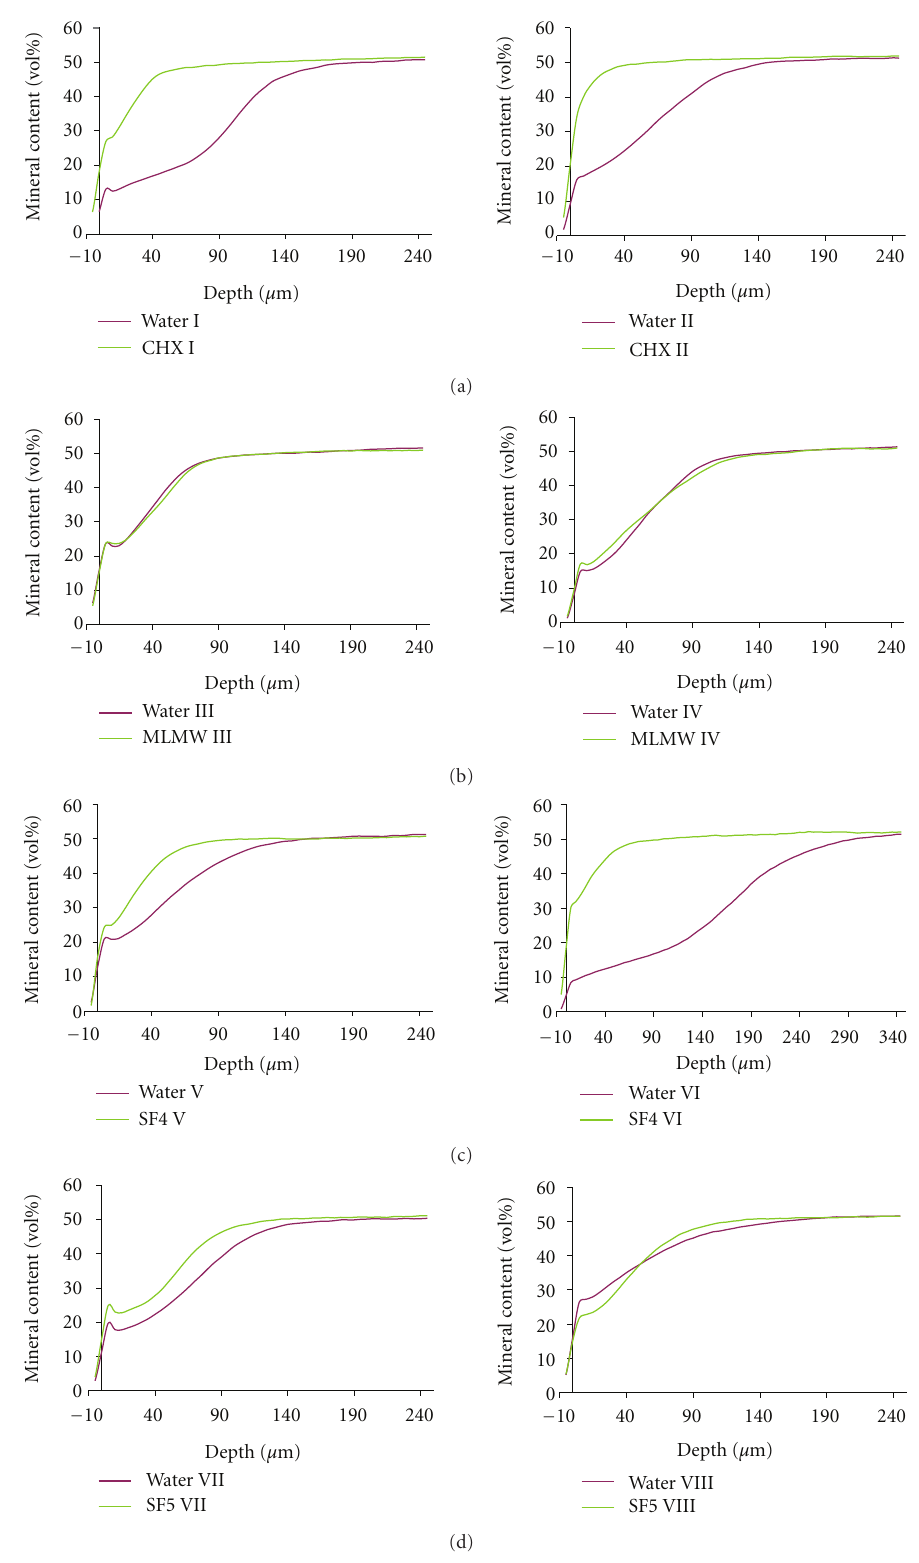
Figure 2: Average mineral content profiles showing the extent of demineralization of dentin after microcosm growth for 8 days in constant depth film fermentor (CDFF) per CDFF run (Roman numbers I–VIII—eight CDFF runs) and per treatment: (a) chlorhexidine digluconate (CHX), (b) mushroom low molecular weight fraction (MLMW), (c) subfraction nr 4 (SF4), and (d) Subfraction nr 5 (SF5) of the MLMW fraction of shiitake extract. The two graphs per treatment are the profiles obtained from the duplicate CDFF runs of the respective treatment. Each profile is an average of the transversal microradiography images obtained from 10 dentin